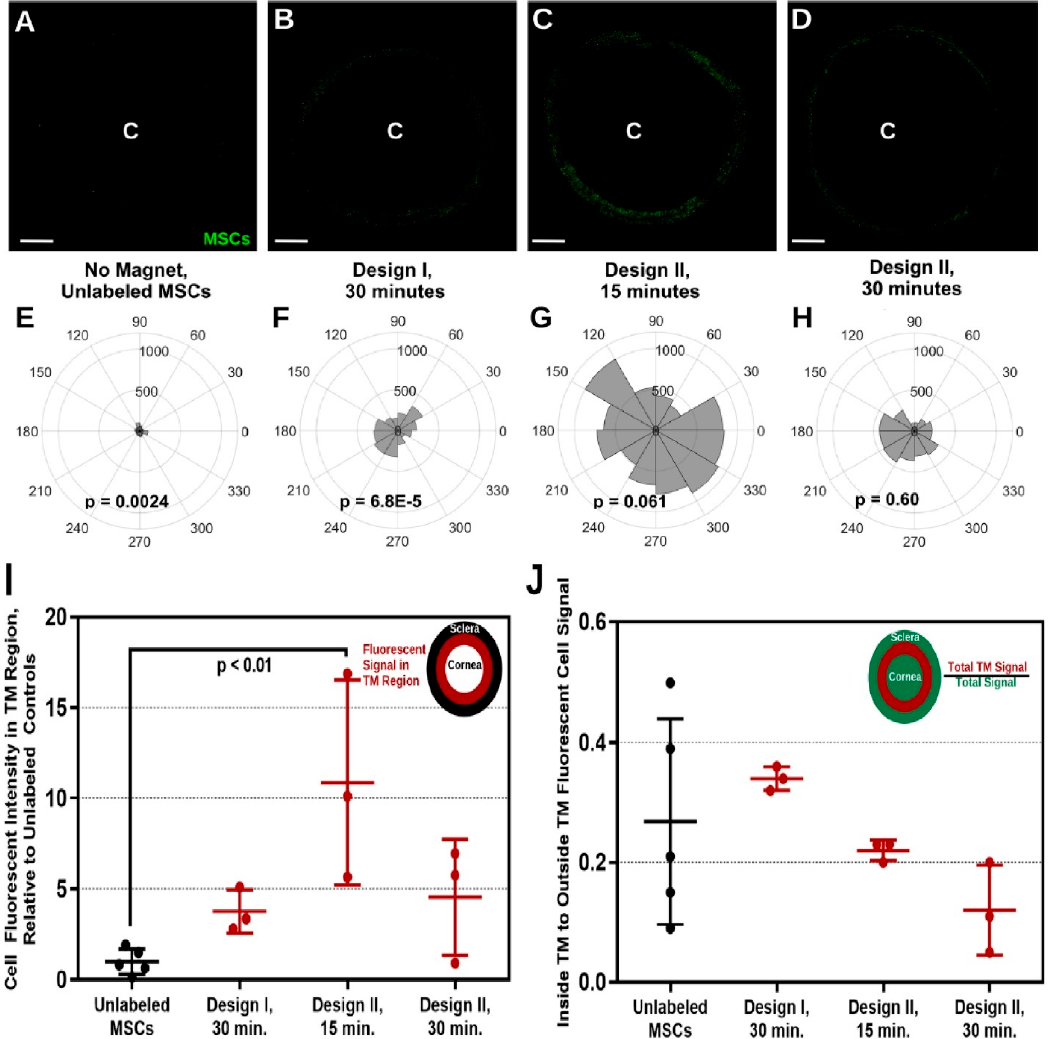
Figure 10. 360° delivery of PBNC-MSCs using ring magnets. Figure (A–D) denotes injection of